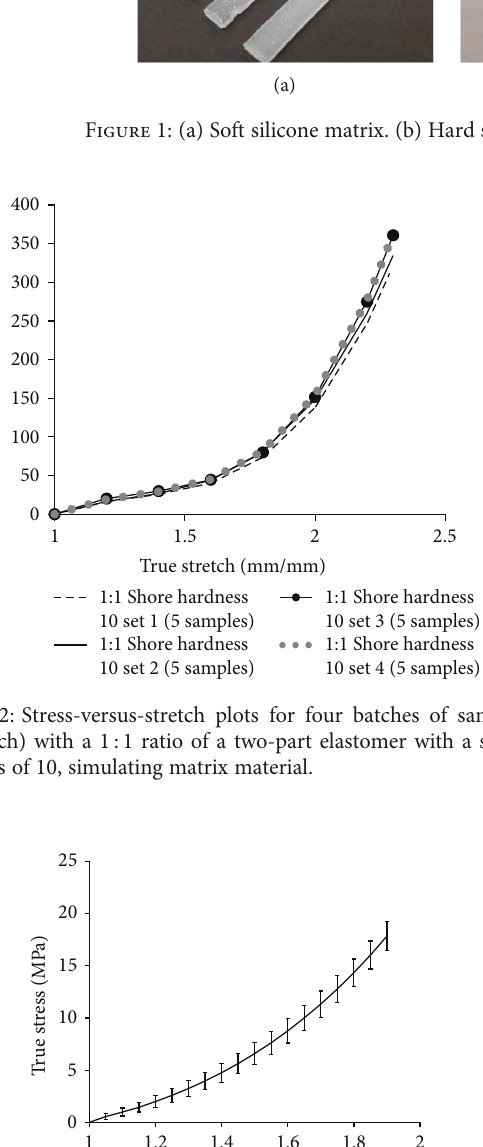
(Figure 4(b)). The e ff ect of variations of the fi ber spacing and number on soft composite mechanical properties were inves- tigated. The overall dimensions of the specimens with one, two, and three fi bers were 35 mm ∗ 10 mm ∗ 3 mm, 35 mm ∗